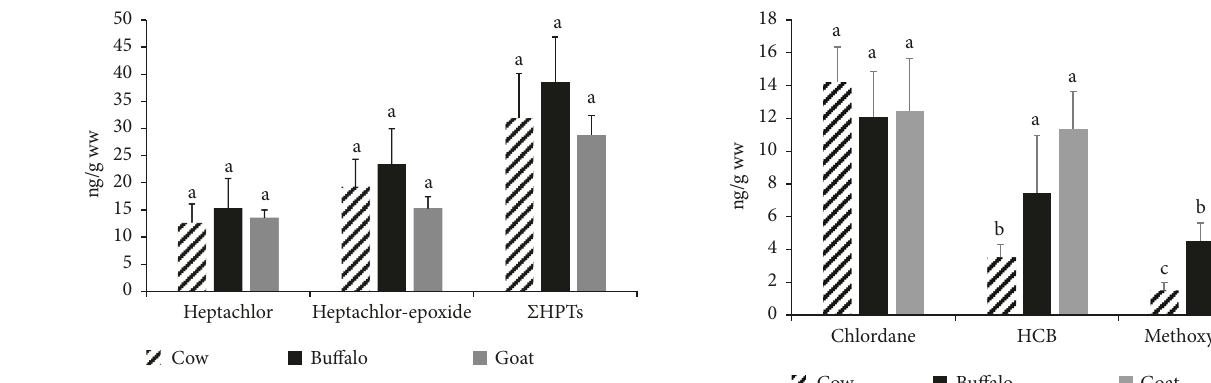
Figure 5: Total heptachlor and its epoxide metabolite in the examined milk samples. Data represent mean ± SE (ng/g ww) for total heptachlor and its epoxide in the examined milk samples from different animal species (n=20 each). Columns that carry same superscript letter among the same chemical are not significantly different at p < 0.05.